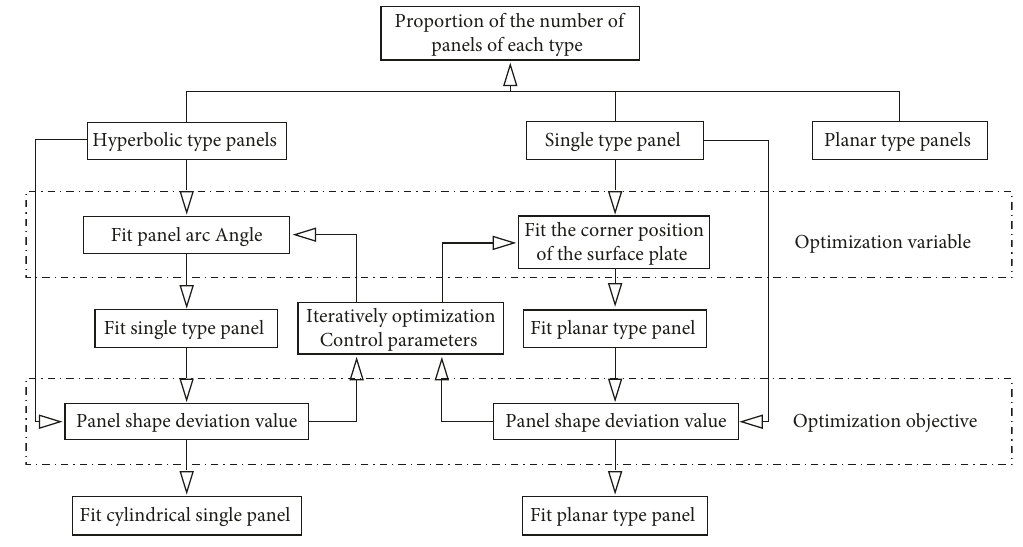
Figure 3: GA single-objective optimization